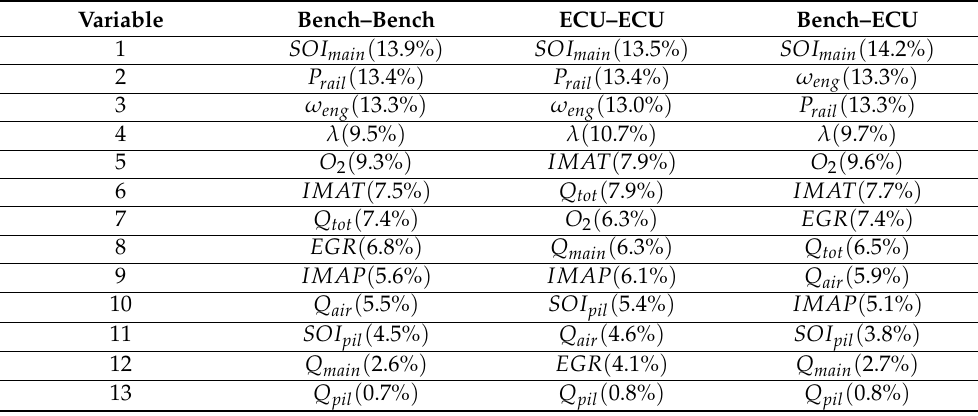
Table 7. The feature importance outputs for the three steady-state cases study which highlight the relative importance of each variable. The green labeling identifies the most influencial engine variables up to reaching 90% of the threshold in the feature importance algorithm for the XGBoost application. Variable